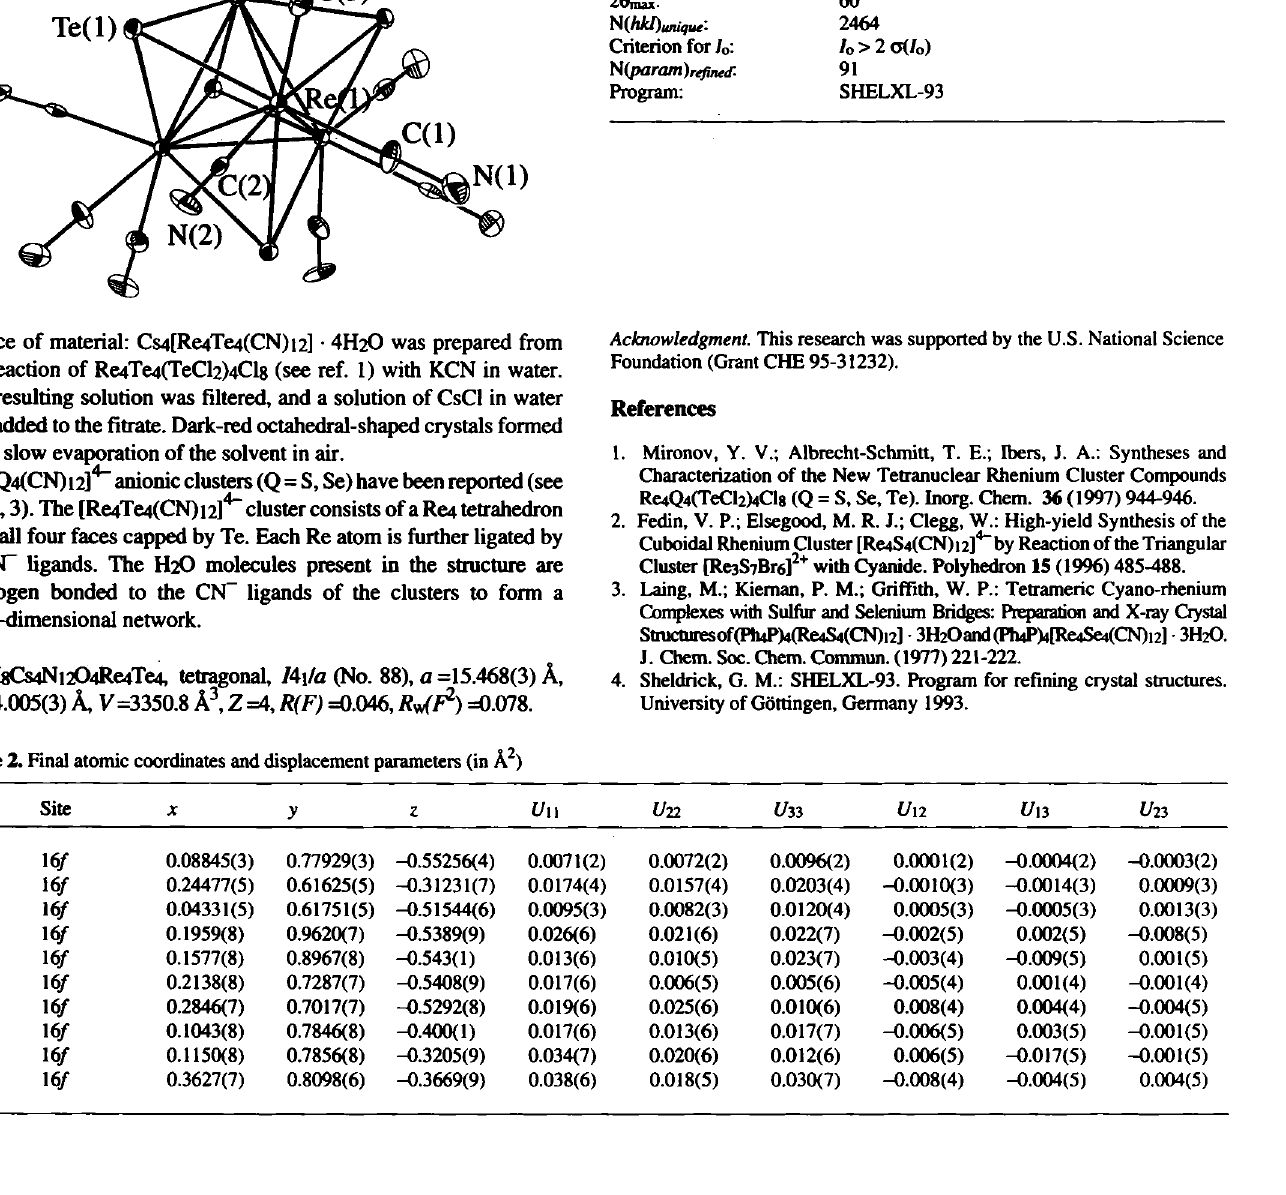
Table 1. Parameters used for the X-ray data collection